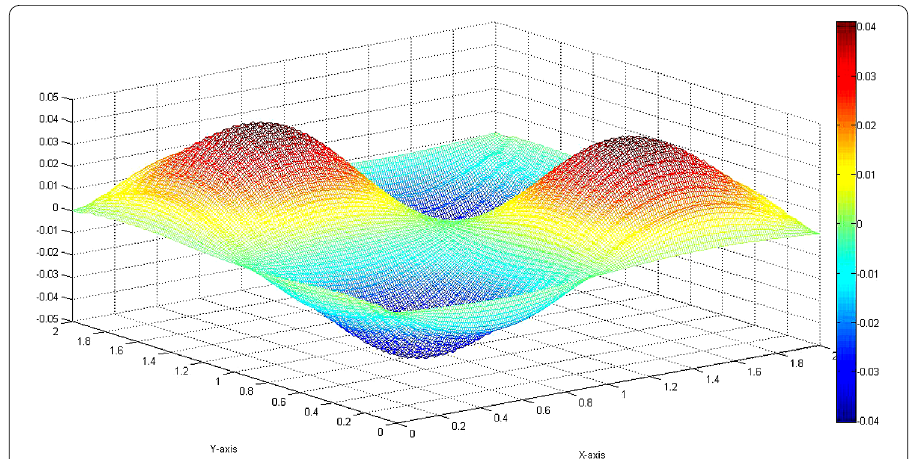
Figure 5 The classical FDCN solution at t = 2.